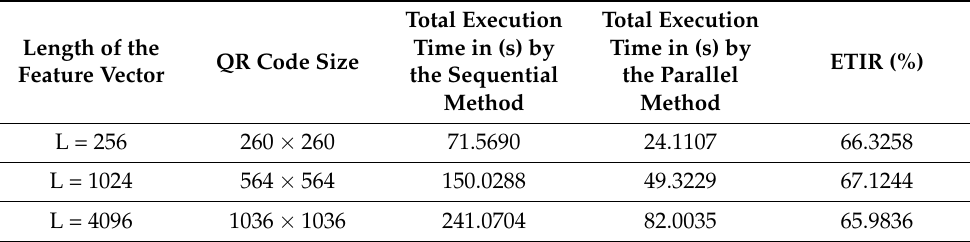
Table 5. Comparison in terms of the average execution time of the proposed scheme using the sequential and parallel methods for feature vector extraction and encryption. Total Execution Total Execution Time in (s) by Time in (s) by Length of the ETIR (%) QR Code Size the Parallel the Sequential Feature Vector Method Method L = 256 260 × 260 71.5690 24.1107 66.3258 L = 1024 564 × 564 150.0288 49.3229 67.1244 L = 4096 1036 × 1036 241.0704